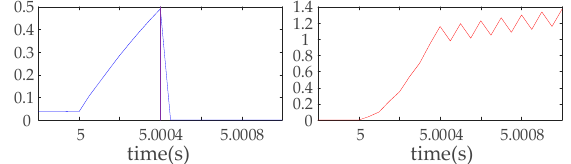
Figure 12. External pole-to-pole fault for Photovoltaic (PV)